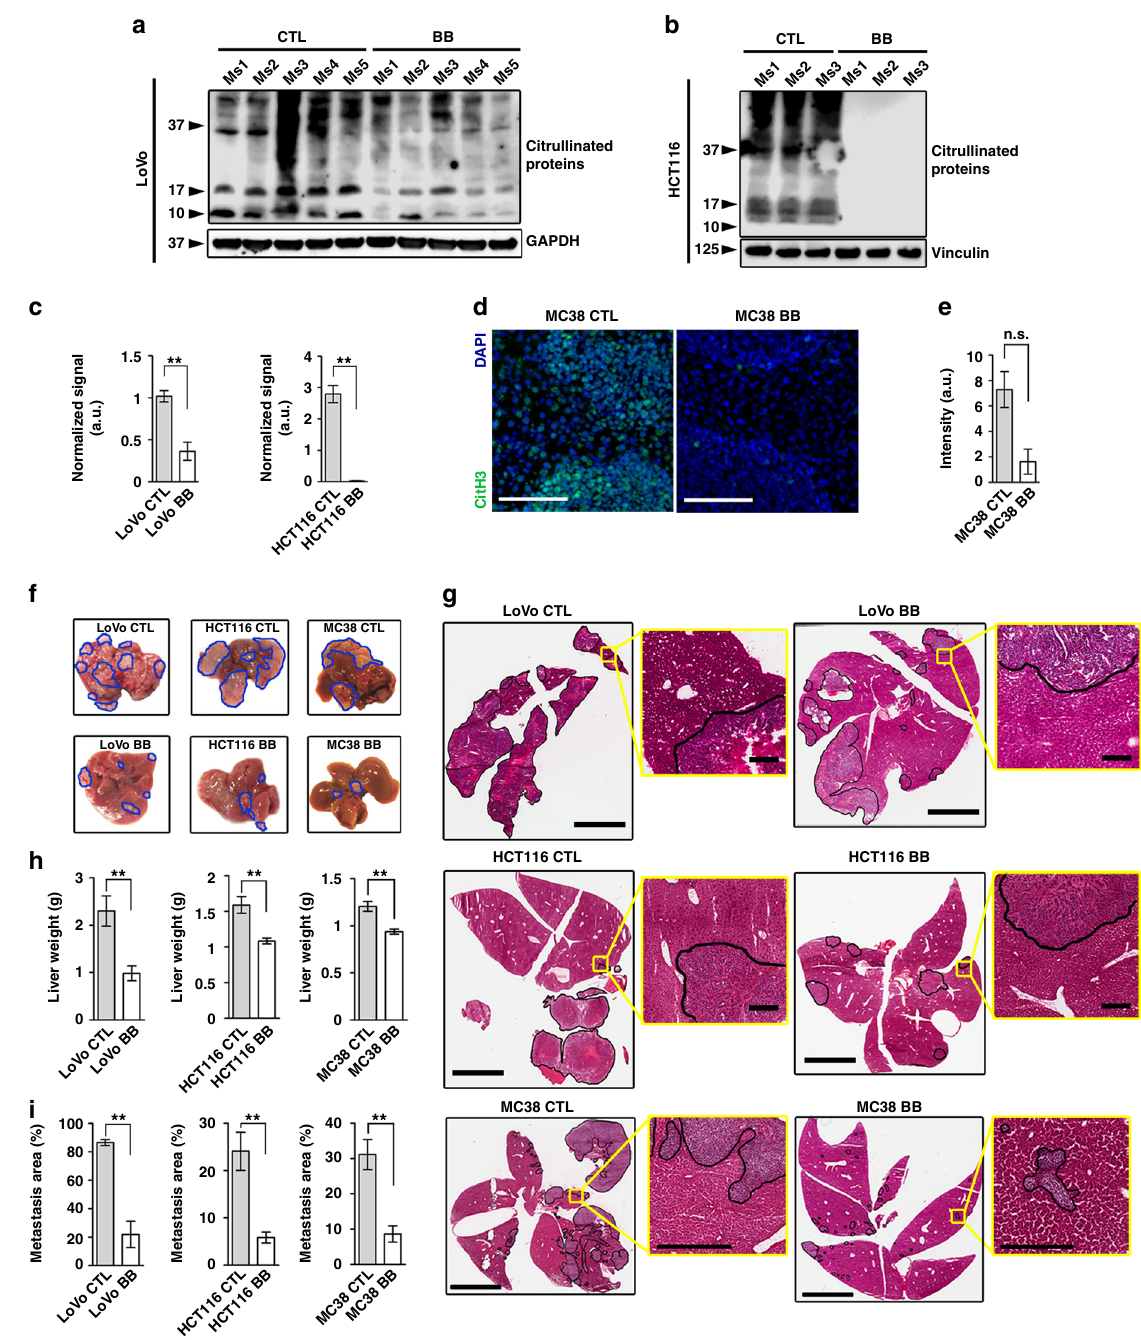
Fig. 5 Pharmacological inhibition of PADs diminishes experimental hepatic metastases in vivo. a , b Immunoblotting for citrullinated proteins performed on tissue lysates extracted from experimental LoVo and HCT116 hepatic metastases from mice treated with vehicle or BB-Cl-amidine. Each lane indicates a biological replicate. GAPDH and Vinculin were used as a loading control. c Densitometric analysis for ( a ) and ( b ). d Representative images of immunostaining for citrullinated Histone H3 in experimental MC38 hepatic metastases from mice treated with vehicle ( n = 5 biological replicates), or BB- Cl-amidine ( n = 6 biological replicates). n = 3 sections per group, three images were analyzed per section. Scale bar = 100 μ m. e Staining intensity quanti fi cation for ( d ). f Representative images of livers with experimental LoVo, HCT116 and MC38 hepatic metastases from mice treated with vehicle ( n = 7, 6, and 5 biological replicates, respectively) or BB-Cl-amidine ( n = 8, 6, and 6 biological replicates, respectively). Metastatic nodules are outlined in blue. Representative of two experiments. g Representative H&E-stained and scanned slides of dissected livers from the experiment in ( f ). Metastatic regions are outlined in black. Scale bar = 4 mm (scale bar of inserts = 200 μ m). h Weight of excised metastasis-bearing livers from the experiment in ( f ). i Metastatic area based on the assessment of H&E-stained sections of livers from the experiment in ( f ). At least three different sections per mouse were analyzed. Throughout, error bars indicate s.e.m. center values indicate mean (** P < 0.01, n.s. = non-signi fi cant, Mann – Whitney U test). CTL control, BB